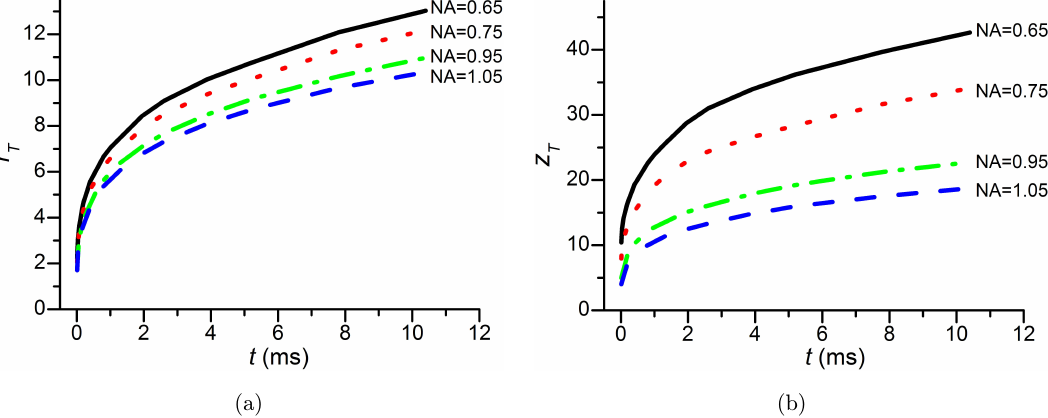
Fig. 5. Calculated FWHMs of temperature rise along both the radial ( T r Þ and axial ( T z Þ axes vs irradiation time, for various NAs as an estimation of temperature distribution. The excitation light is 20 mW at 1700